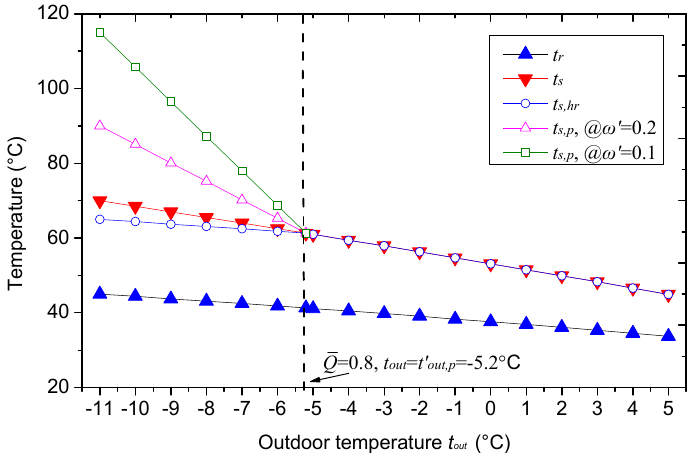
Figure 7. Variation of supply water temperature of the gas-fired boiler ( t s,p ) and heat exchanger ( t s,hr ) with outdoor temperature under working condition for series connection.